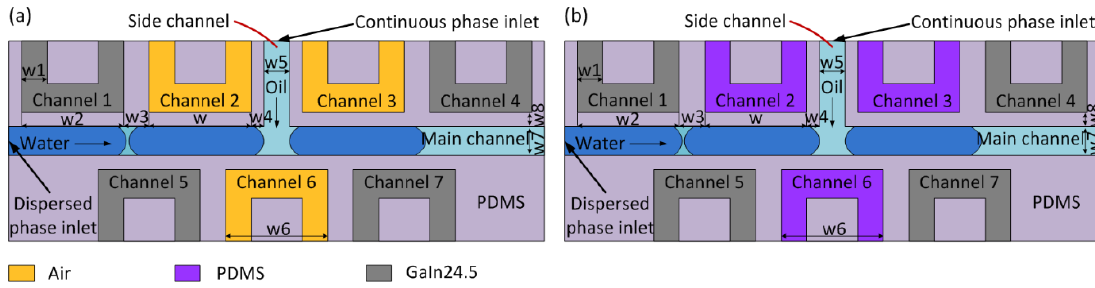
Figure 1. Structure of the dielectrophoresis droplet generator. ( a ) Droplet generator of scheme 1; ( b ) ( b ) droplet generator of scheme 2. The only di ff erence between scheme 1 and scheme 2 was the filling droplet generator of scheme 2. The only difference between scheme 1 and scheme 2 was the filling material of non-electrode Channel 2 / 3 / 6, with air in scheme 1 and PDMS in scheme material of non-electrode Channel 2/3/6, with air in scheme 1 and PDMS in scheme 2.